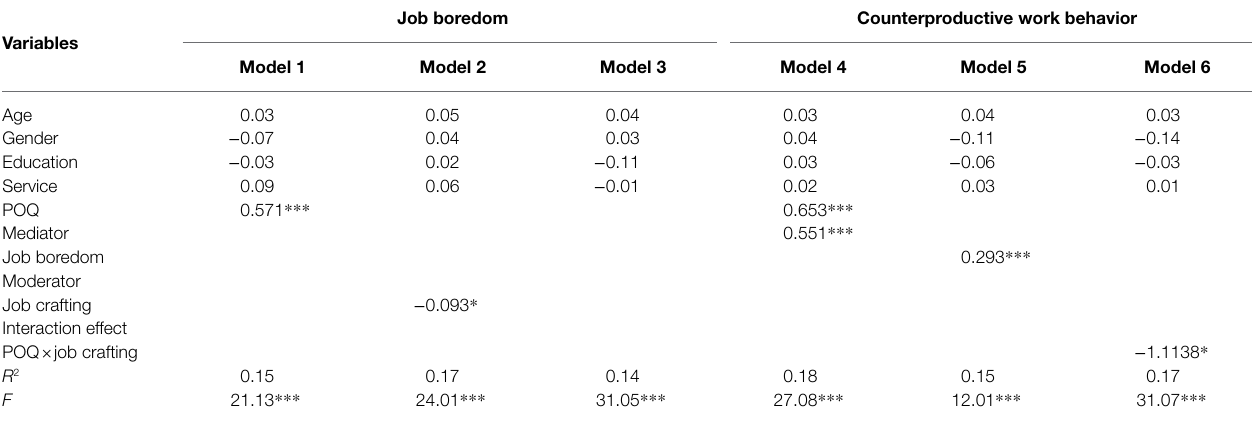
TABLE 4 | Hierarchical linear regression